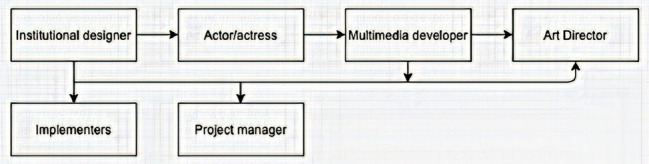
Coordination of content production team. Adapted from Parente (2010).